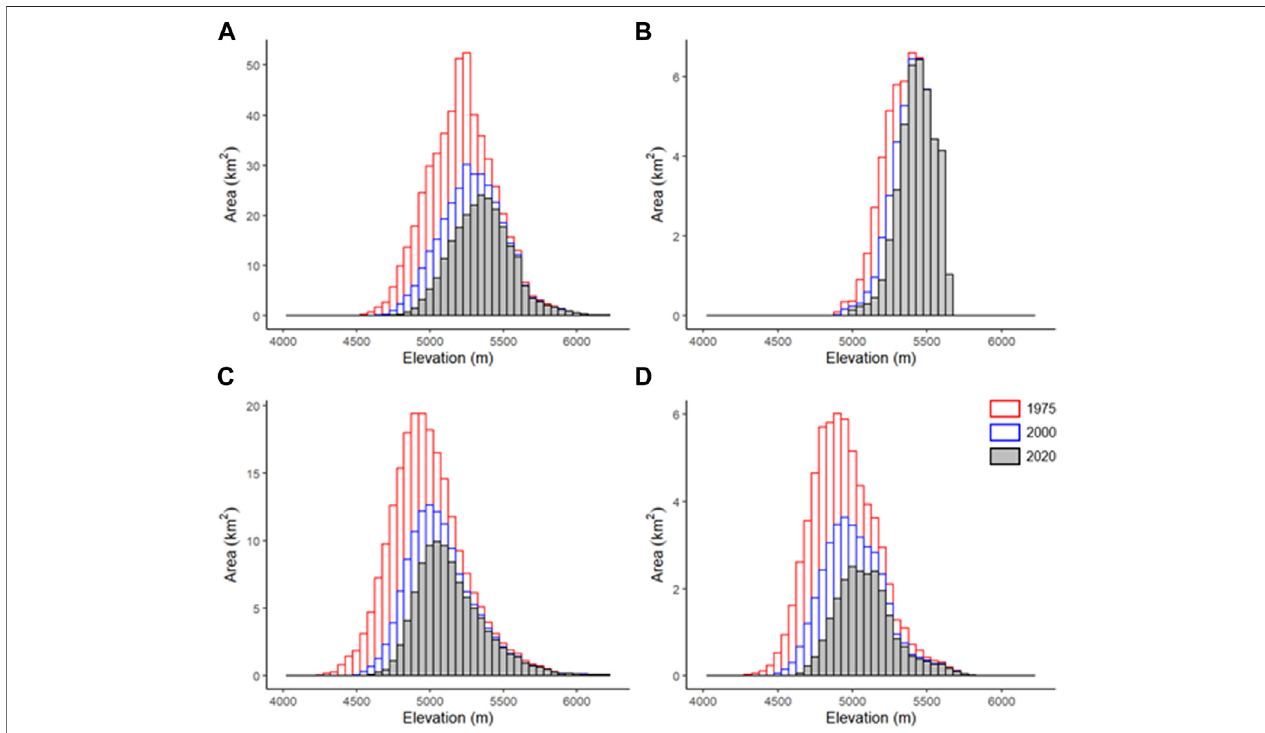
FIGURE 3 | Evolving glacier hypsometry (1975, 2000, and 2020) in 50 m elevation bins for the (A) Cordillera Vilcanota, (B) Quelccaya ice cap, (C) Cordillera Vilcabamba, (D) Cordillera Urubamba. Note varying y -axis in each graph.